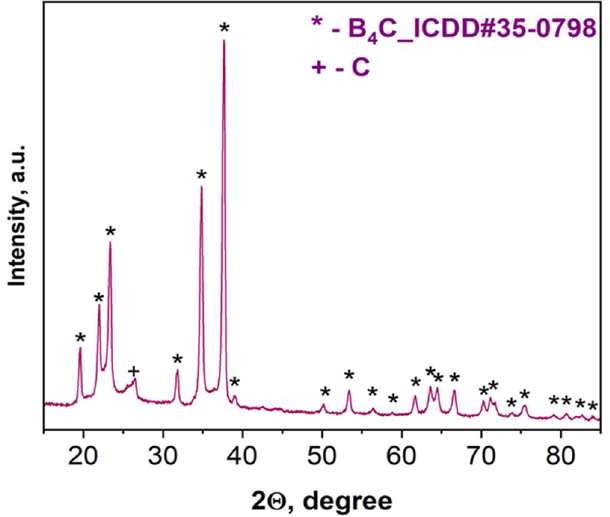
Figure 3. XRD pattern of the combustion product derived from the B 2 O 3 + 0.2MgB 12 + 2.8Mg + 1.1C mixture after acid leaching.